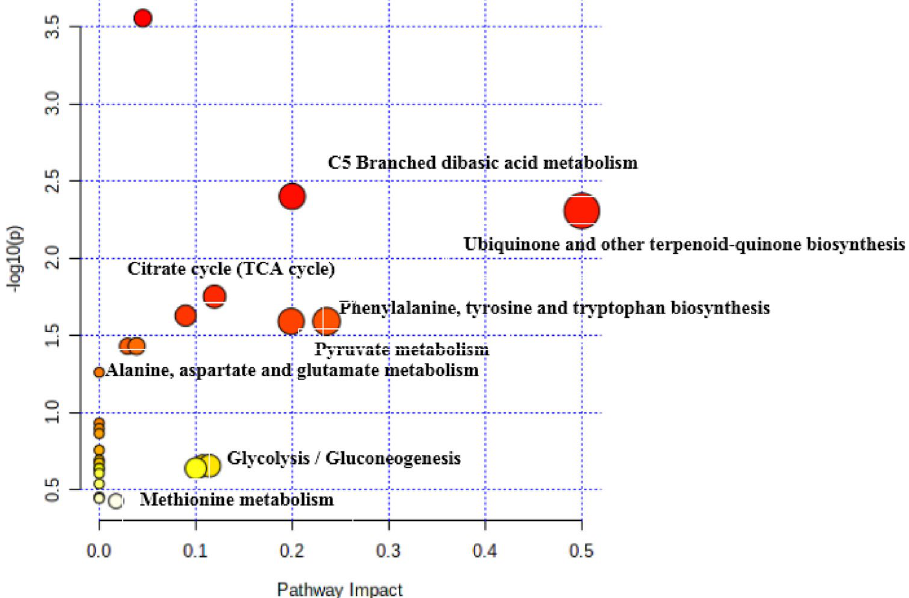
Figure 7. Metabolomic pathway analysis of Quercetin treated Serratia marcescens metabolome by MetaboAnalyst 3.0 Software according to KEGG pathway database. The darker the color and larger the size represent higher P-value from enrichment analysis and greater impact from the pathway topology analysis,